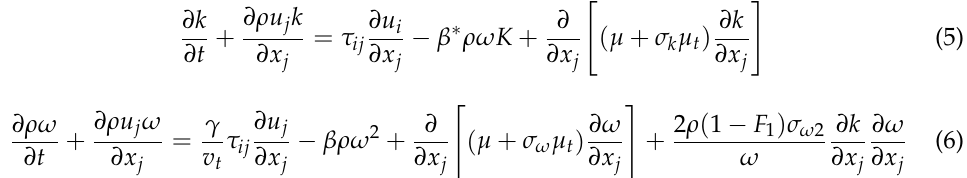
Figure 1. ( a ) The centrifugal pump; ( b ) The ring seals, impeller and vaned diffuser; ( c ) Flow in the seal; ( d ) 3D model of flow domain; ( e ) CFD mesh.